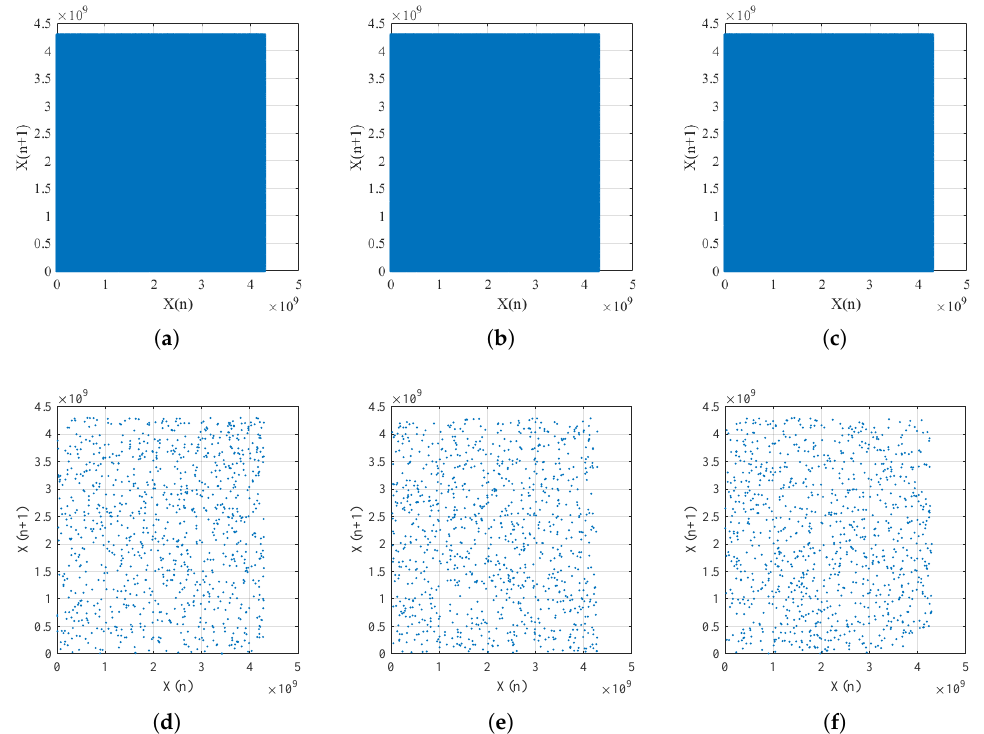
Figure 9. Phase space and zoom of the produced sequences X1, X2, and X3 by LSP-PRNG, LST-PRNG, and LSPT-PRNG, respectively. ( a ) Mapping of sequence X1. ( b ) Mapping of sequence X2. ( c ) Mapping of sequence X3. ( d ) Zoom on the mapping of X1. ( e ) Zoom on the mapping of X2. ( f ) Zoom on the mapping of X3.